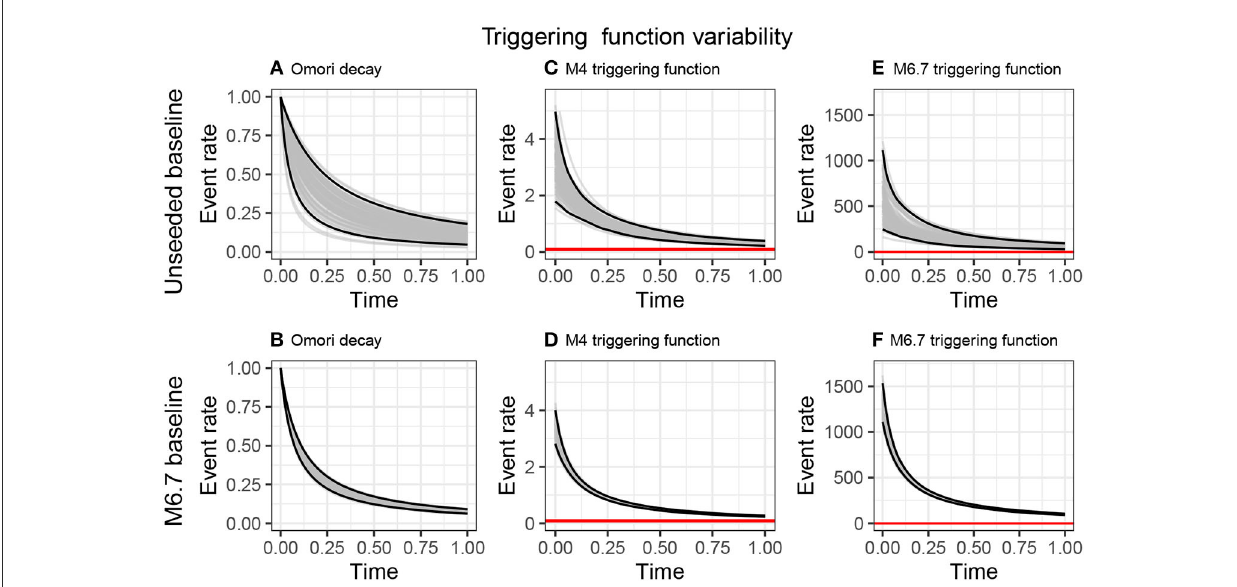
FIGURE5 Propagation of ETAS parameter uncertainty on the triggering functions. We take 100 samples of the ETAS posteriors for the 1,000-day quiescent baseline (A, C, E) and the 1,000-day catalog with an M6.7 on day 500 (B, D, F) and use these samples to explore variability in the Omori decay (A, B) , the time-triggering function following an M4 event, and the time-triggering function following an M6.7